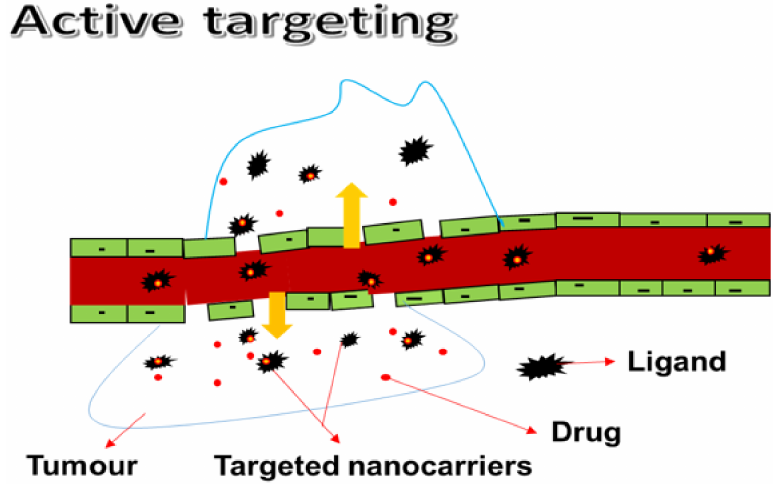
Figure 2. Active